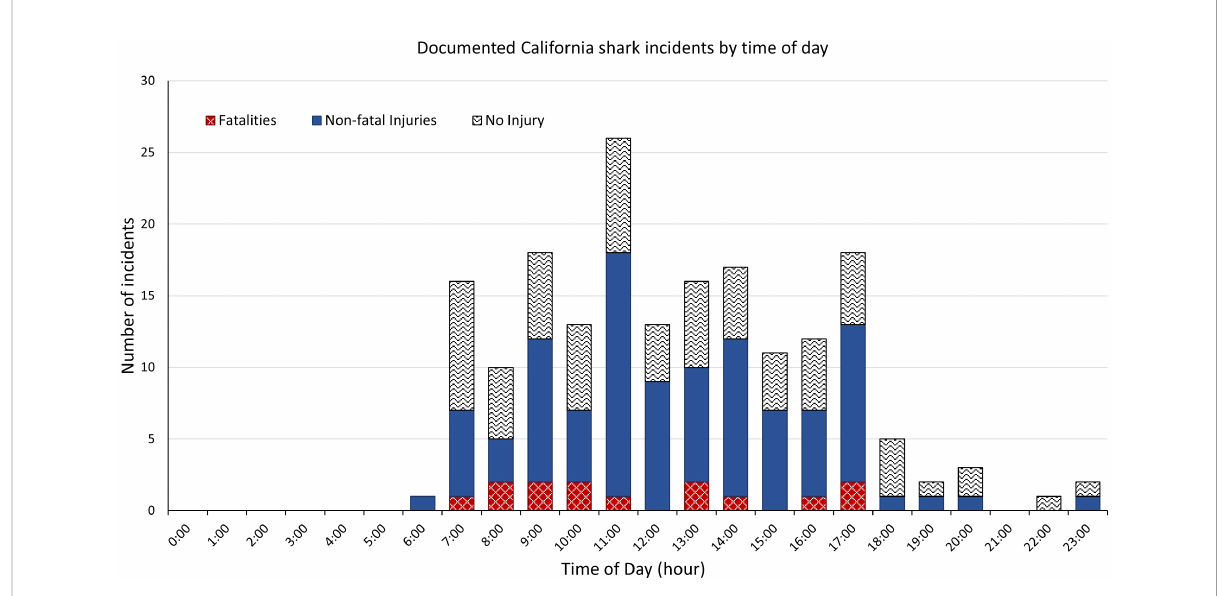
FIGURE 6 Time of day of documented California shark incidents by category, non-injury incidents, non-fatal injuries, and fatalities, 1950 to